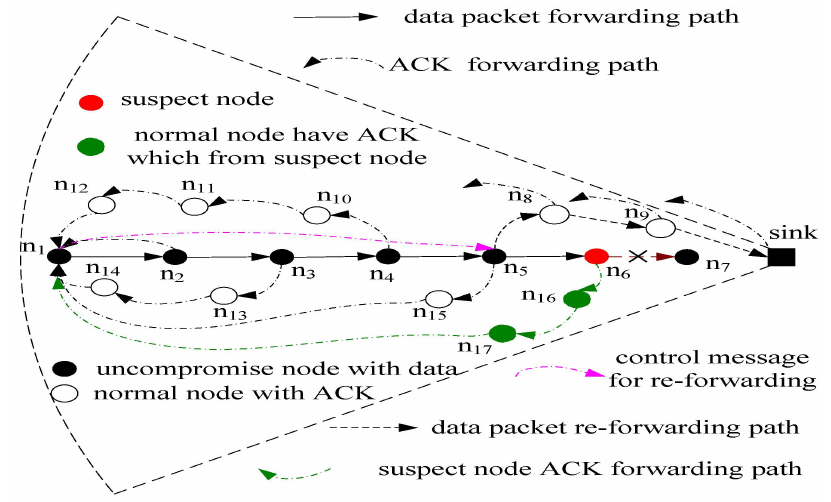
Figure 2. Illustration of the PHACK